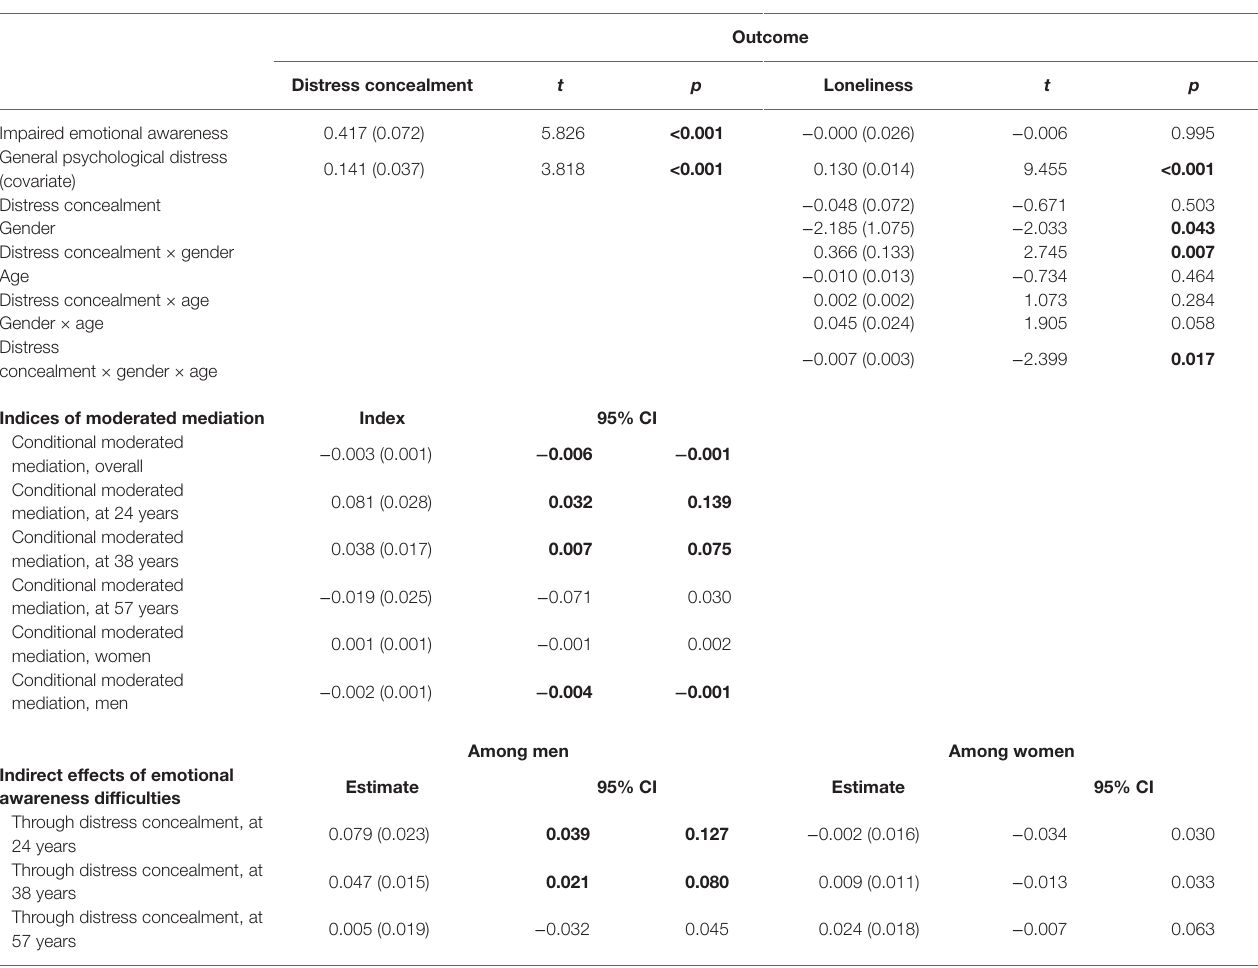
TABLE 1 | Regression coefficients (with SEs) examining second-stage conditional moderated mediation to loneliness.